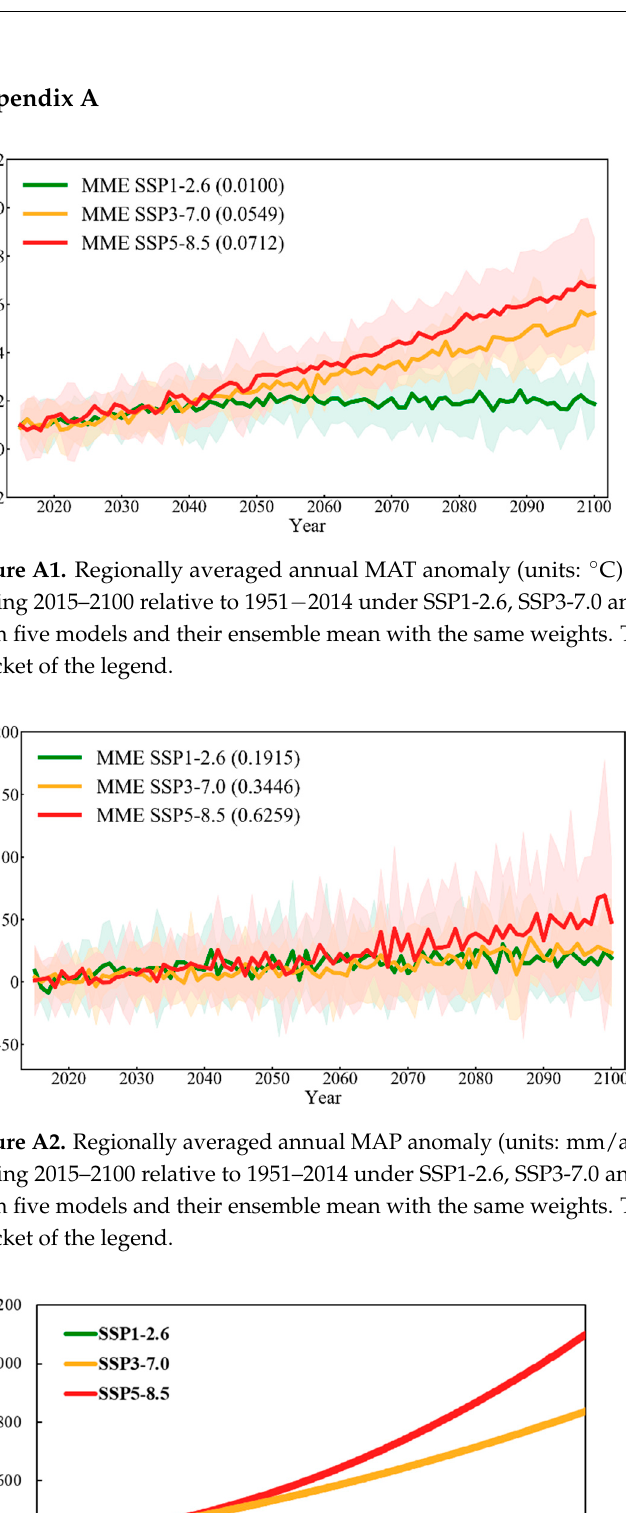
Figure A4. Comparison and interactive verification of CUE of different research results over the Qinghai-Tibet Plateau during 2000–2010. The thick red line represents the CUE of the multiple model ensemble average in this study (MME).